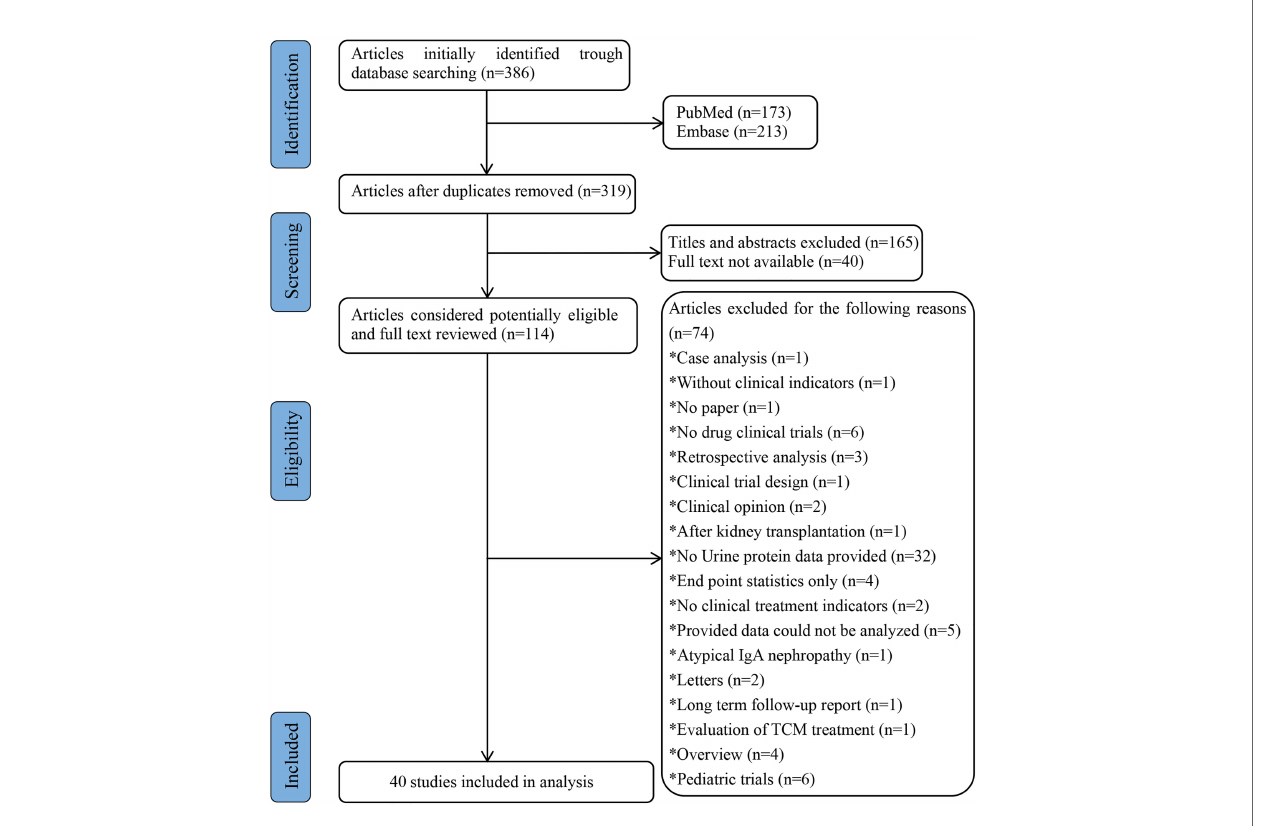
FIGURE 1 | Flow chart of literature screening.